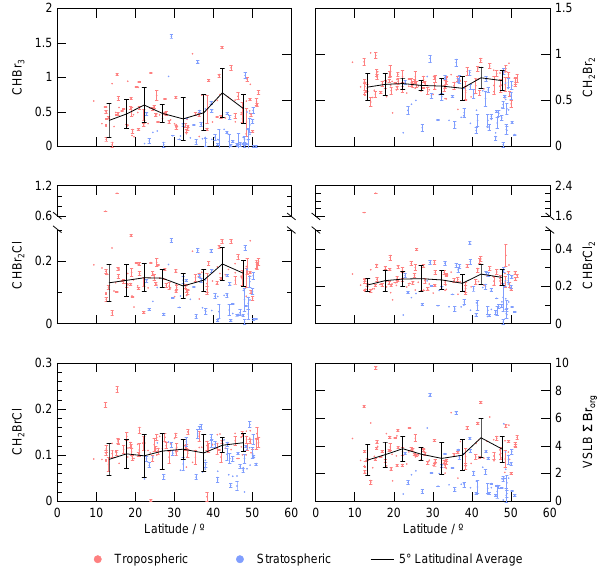
Fig. 3. Northern-hemispheric latitudinal distributions in Central American flights of VSLB and total VSLB-derived bromine (VSLB 6 Br org ) for tropospheric samples, samples classified as having some stratospheric influence (following the definition in Sect. 3) and 5 ◦ latitudinal means of tropospheric samples above 10km alti- tude with 1 σ error bars representing variability. Error bars on indi- vidual samples represent analytical uncertainties. All VSLB values on the vertical axes are given in